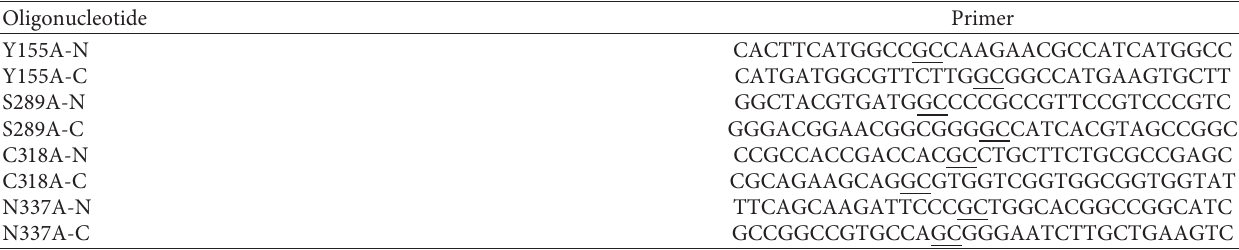
Table 1: Primers used for construction of plasmids.